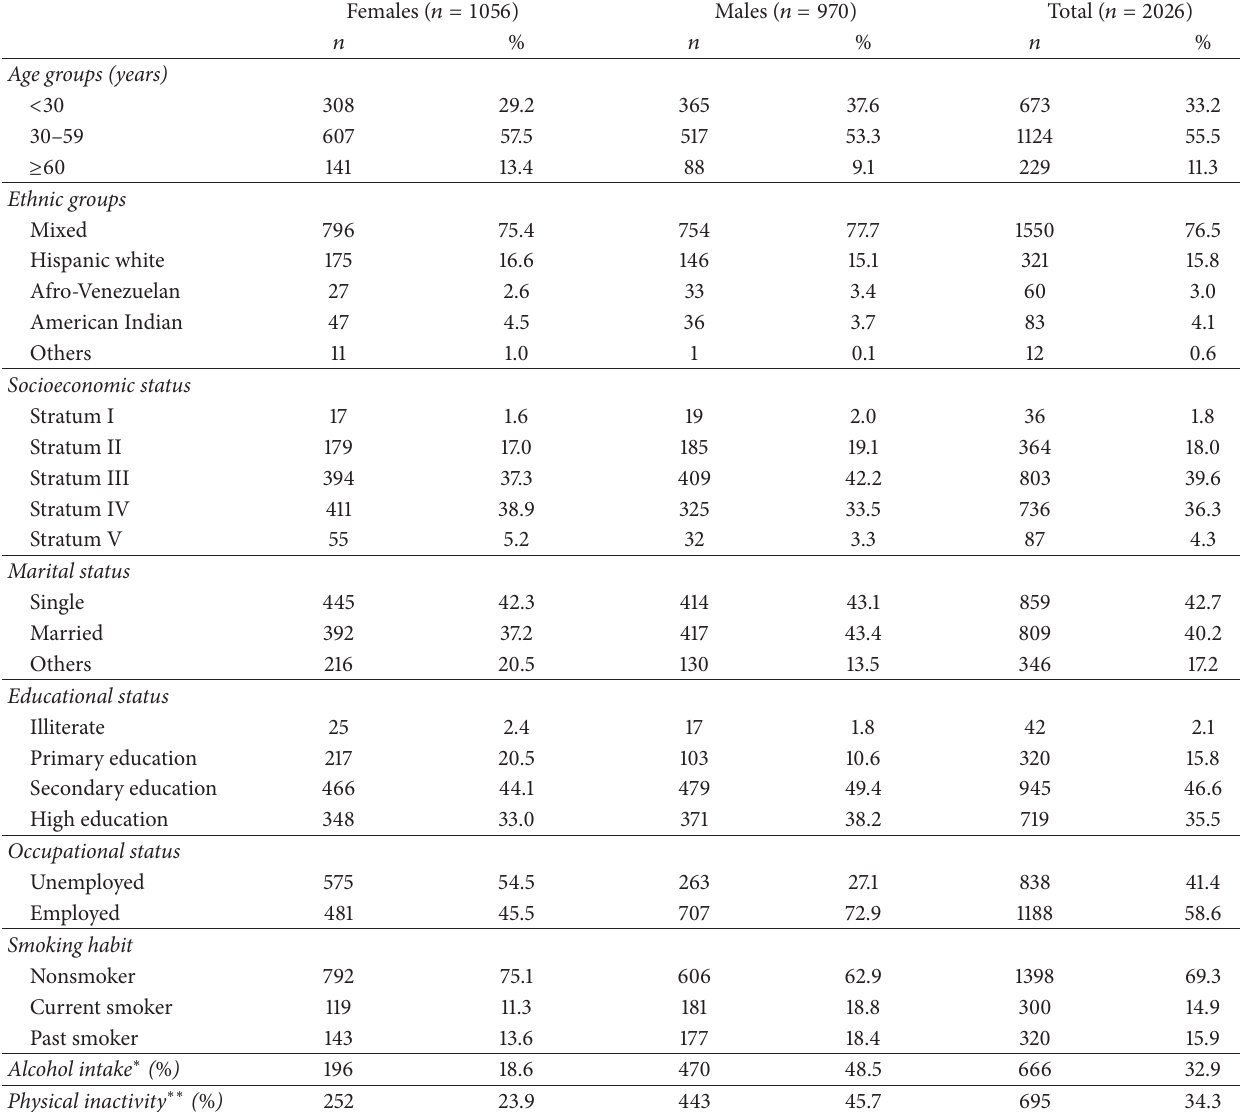
Table 2: Sociodemographic and psychobiologic characteristics of the population by gender (Maracaibo, Venezuela,